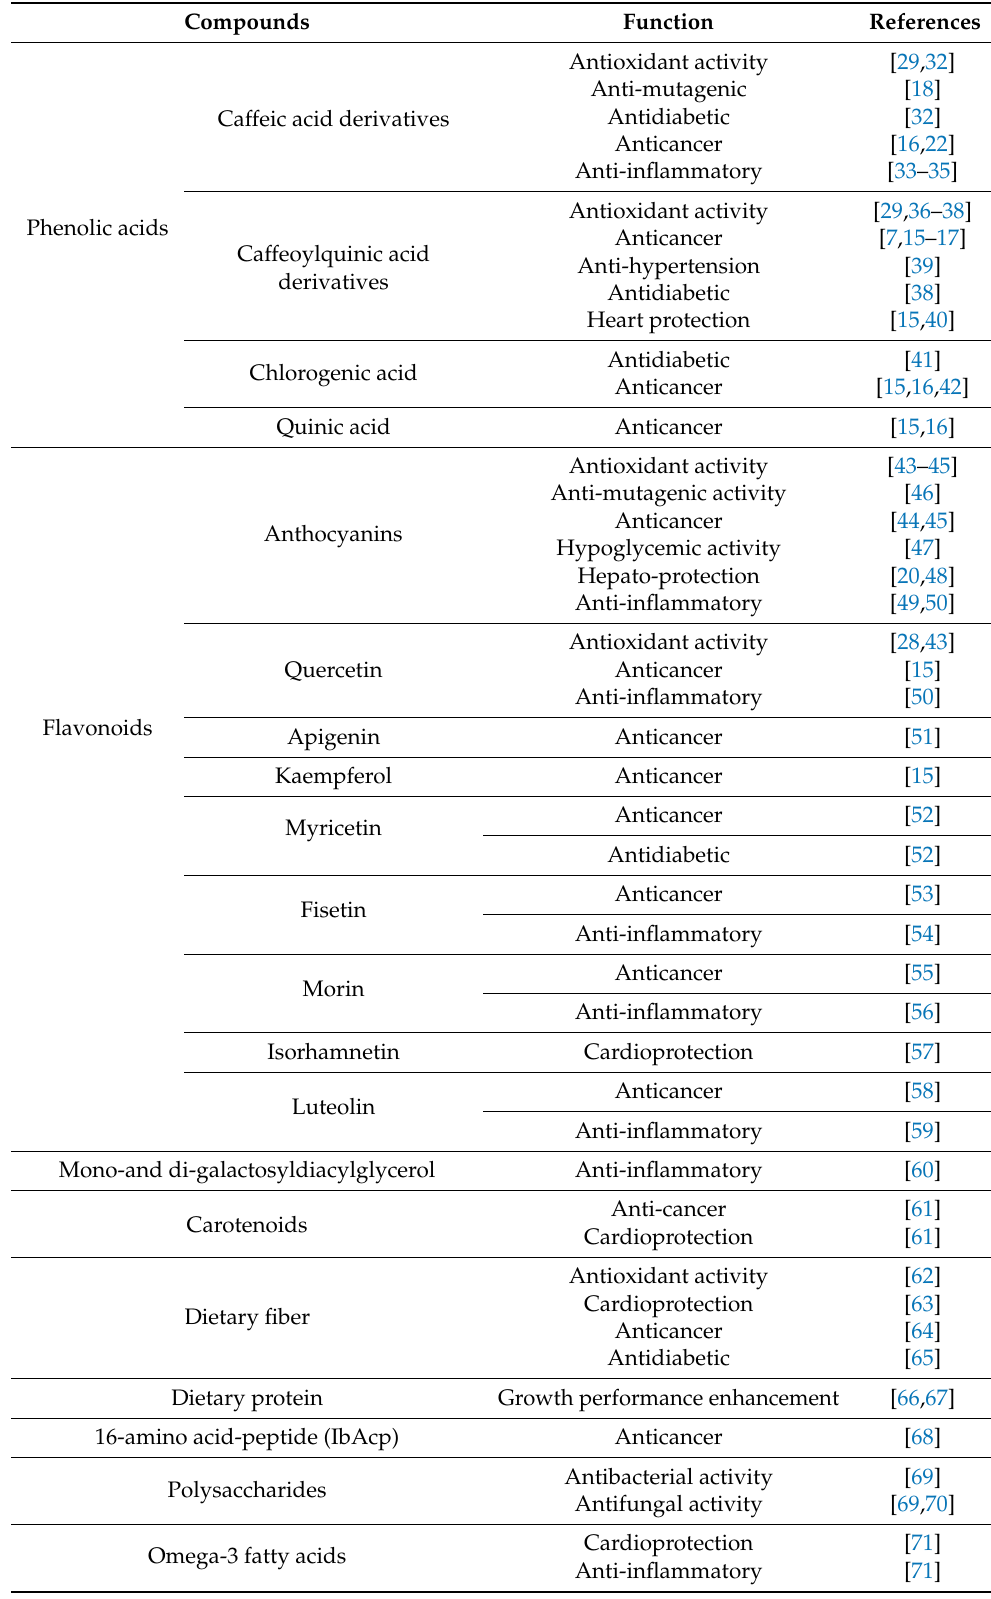
Table 2. Health benefits of bioactive compounds in sweet potato